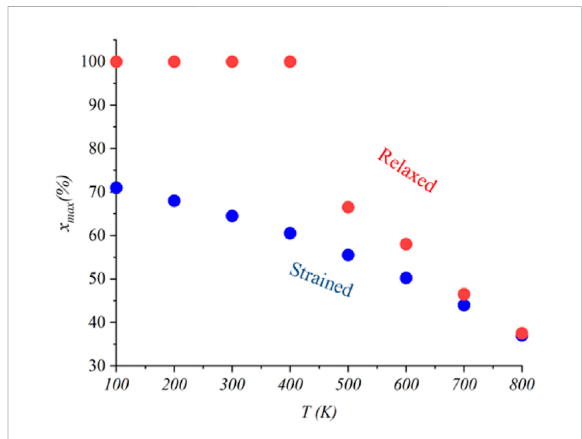
FIGURE 13 x max forthemaximumef fi ciency atdifferenttemperaturesfor relaxed and strained structures.